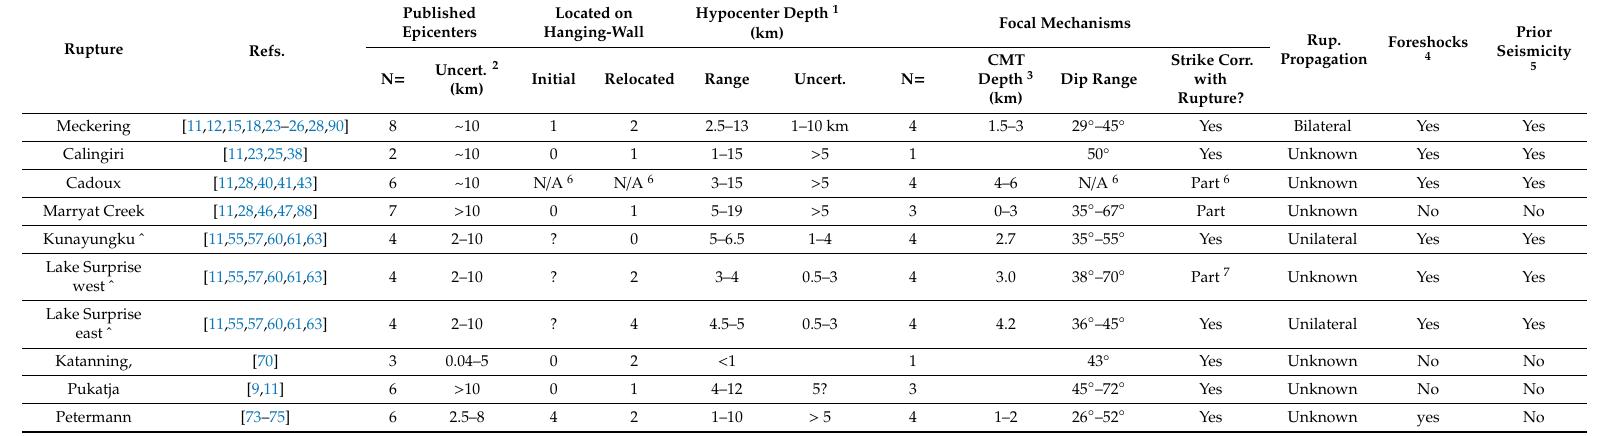
Table 5. Summary of seismological data and interpretations for each